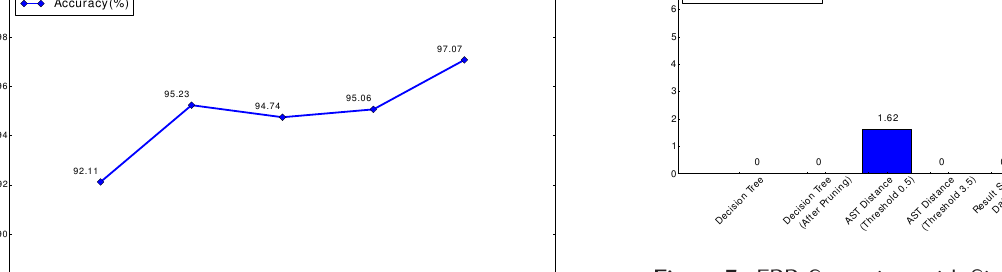
Figure 7. FPR Comparison with Single Stage Detection